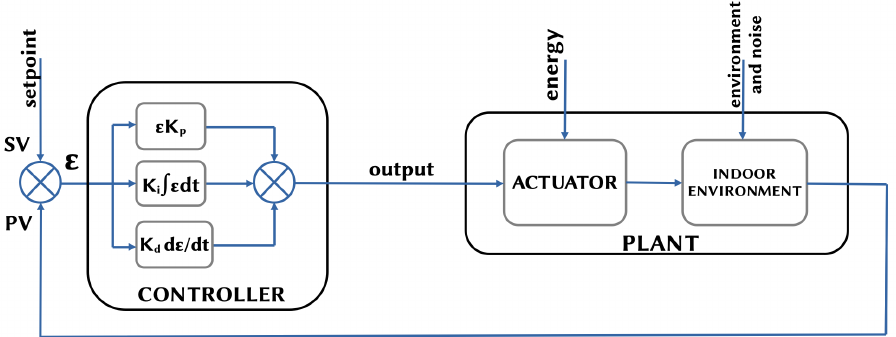
Figure 3. Classical PID controller block